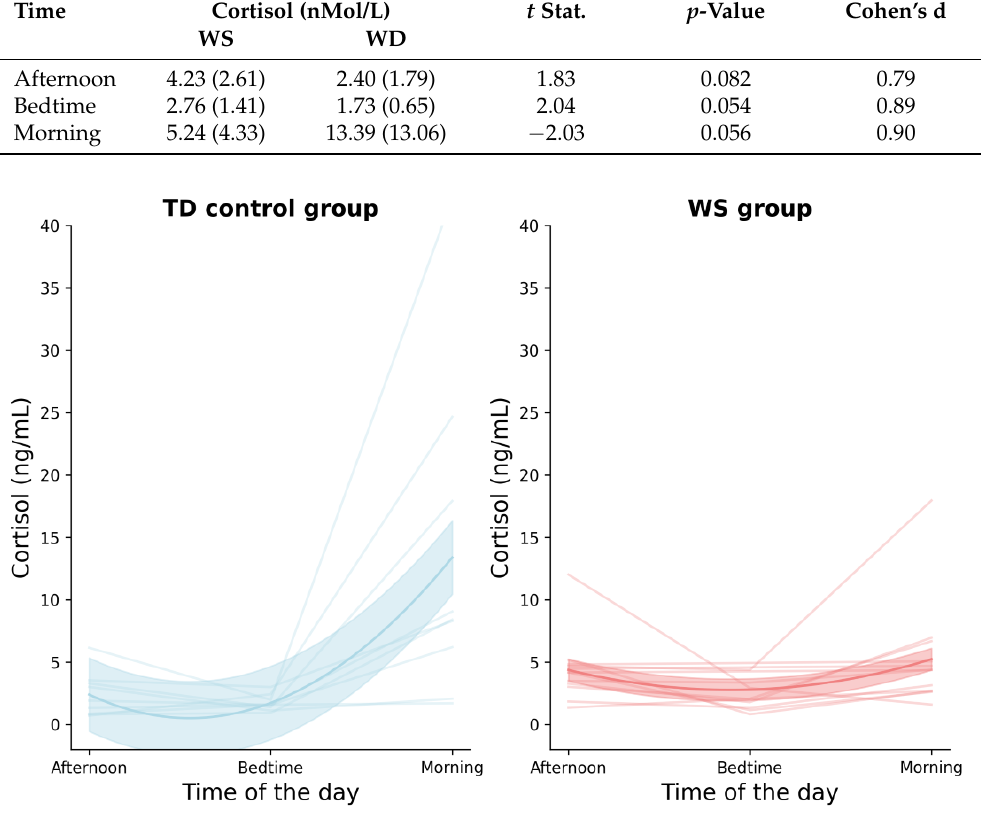
Table 5. Means (and standard deviations) of cortisol concentration at baseline (afternoon), bedtime, and morning for WS and TD groups.